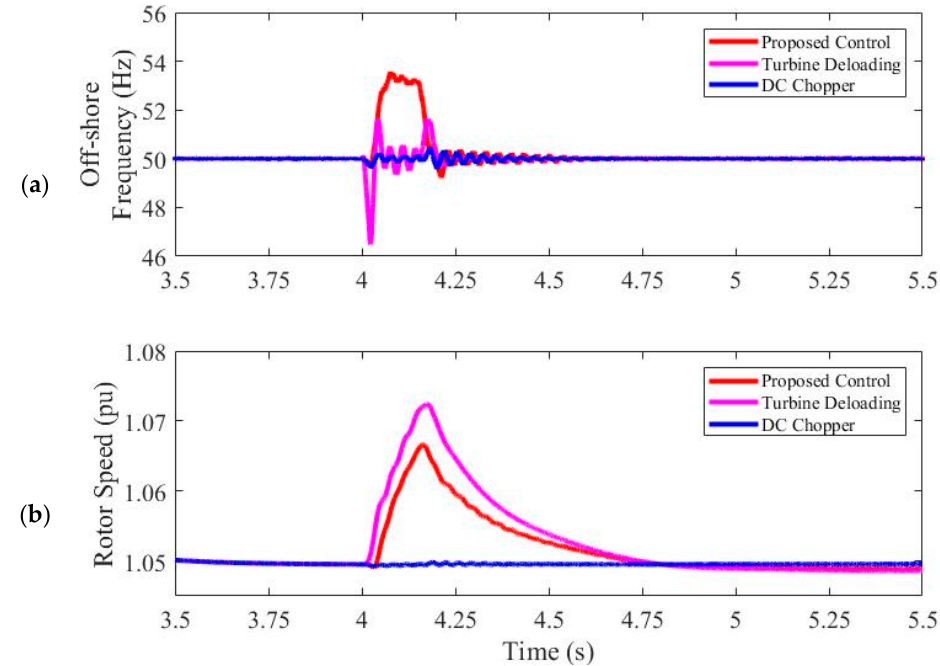
Figure 11. Simulation results of the on-shore fault scenario with a 2.95 Ω fault resistance. ( a ) On-shore AC voltage for each simulation case. ( b ) Off-shore AC voltage for each simulation case. ( c ) Rectifier-side DC voltage for each simulation case.